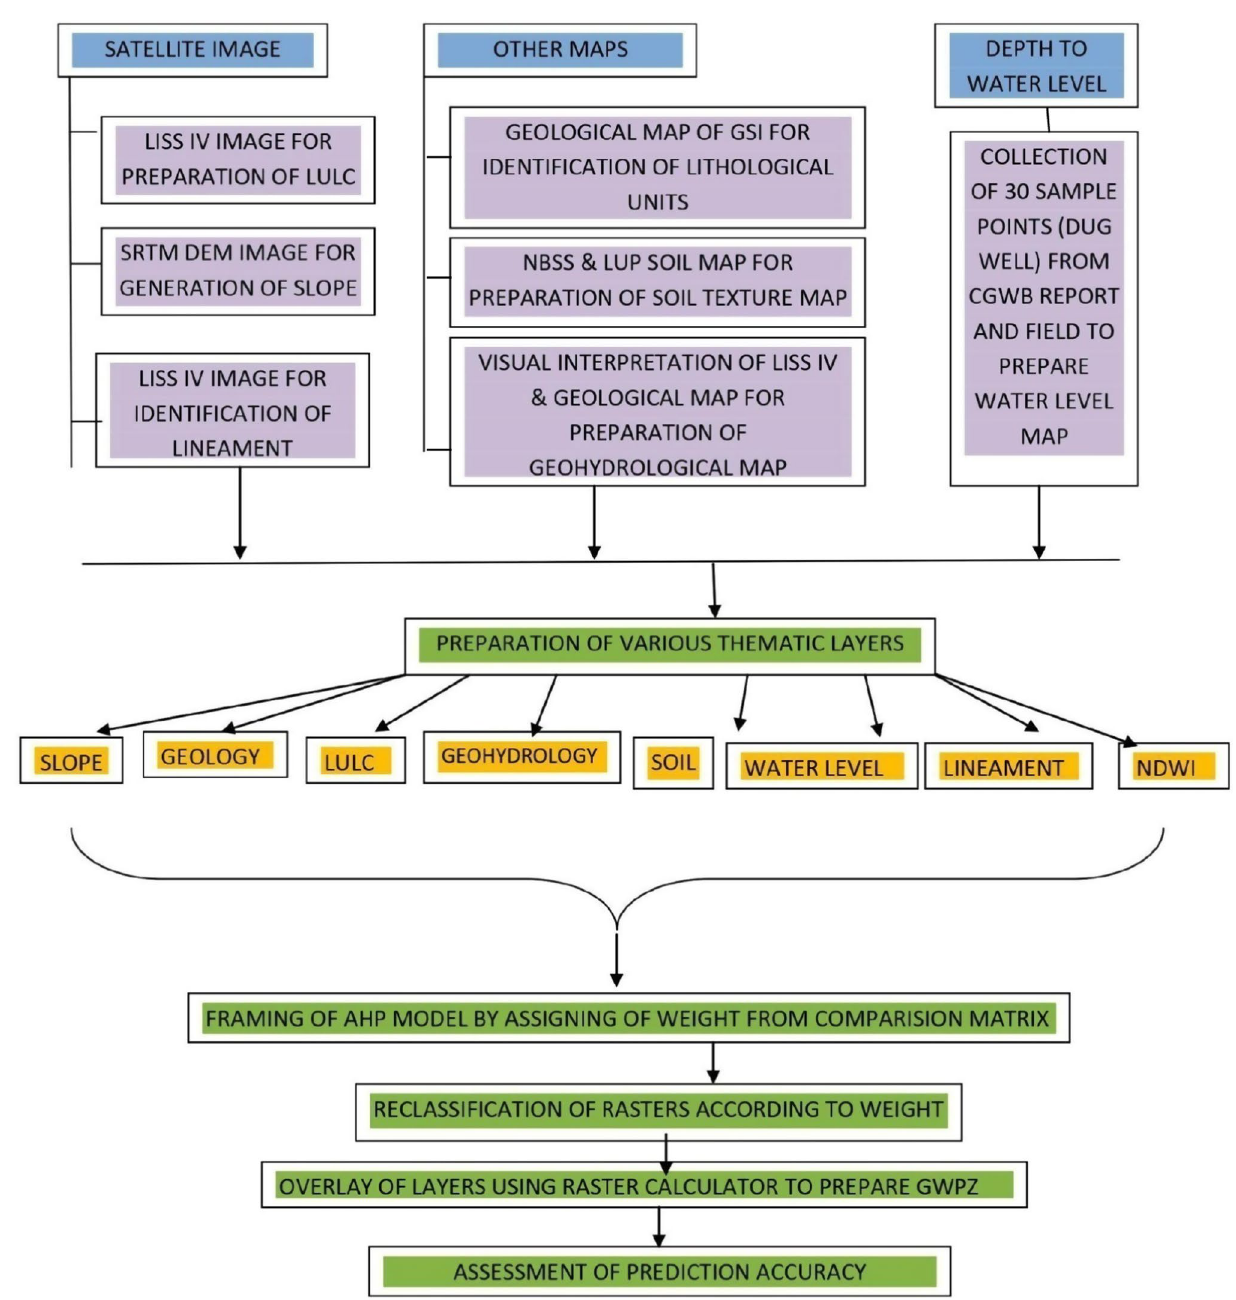
Fig. 2 Methodological framework of the